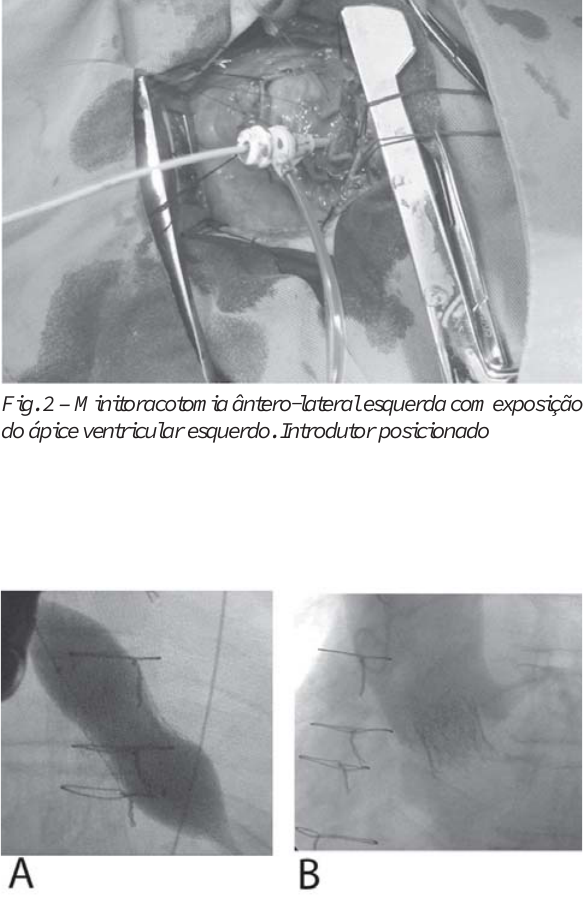
Fig. 3 – A: Balão insuflado com expansão da prótese. B: